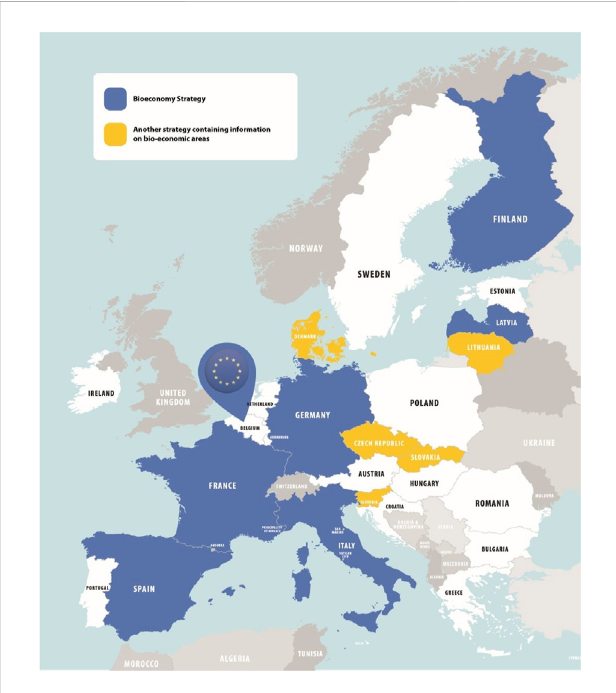
FIGURE 1 EU map showing selected states and their approach to BE (graphic processing by the